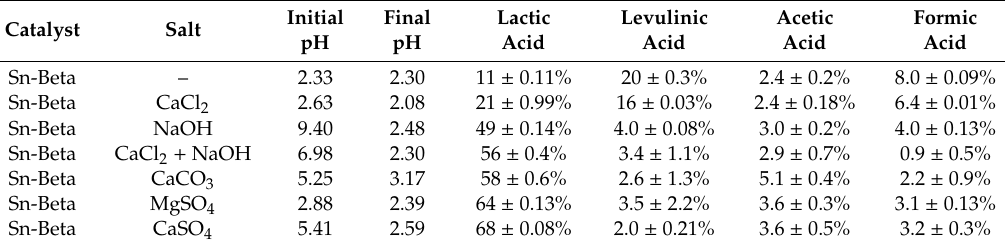
Table 4. Evaluation of Lewis acid and Brønsted base e ff ects on Sn-Beta catalyzed reaction of glucose